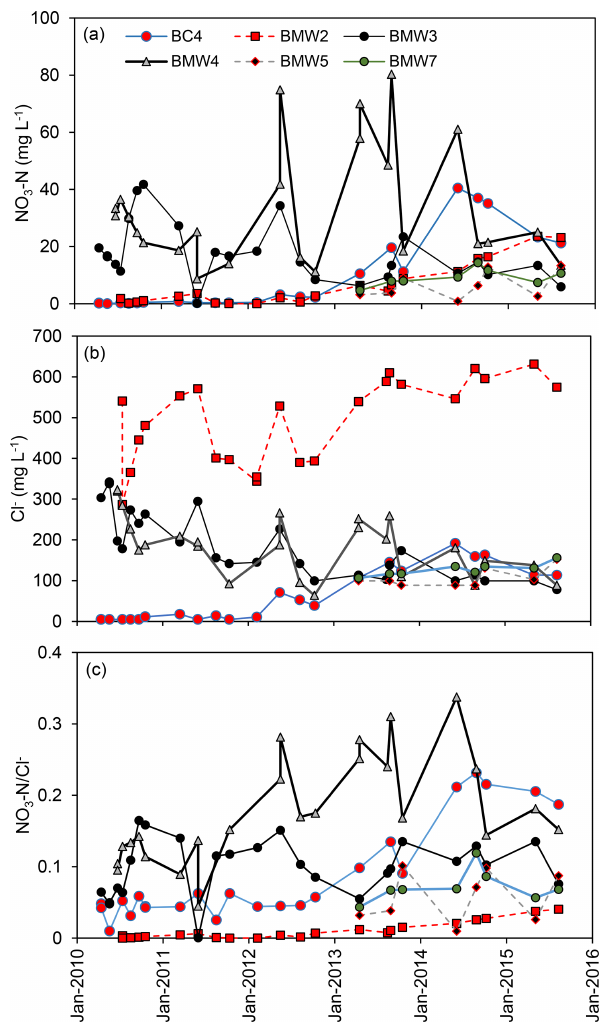
Figure 5. Temporal variations in (a) NO 3 − N, (b) Cl − , and (c) NO 3 − N / Cl − at CFO4. Only wells with NO 3 − N > 10mgL − 1 are shown.